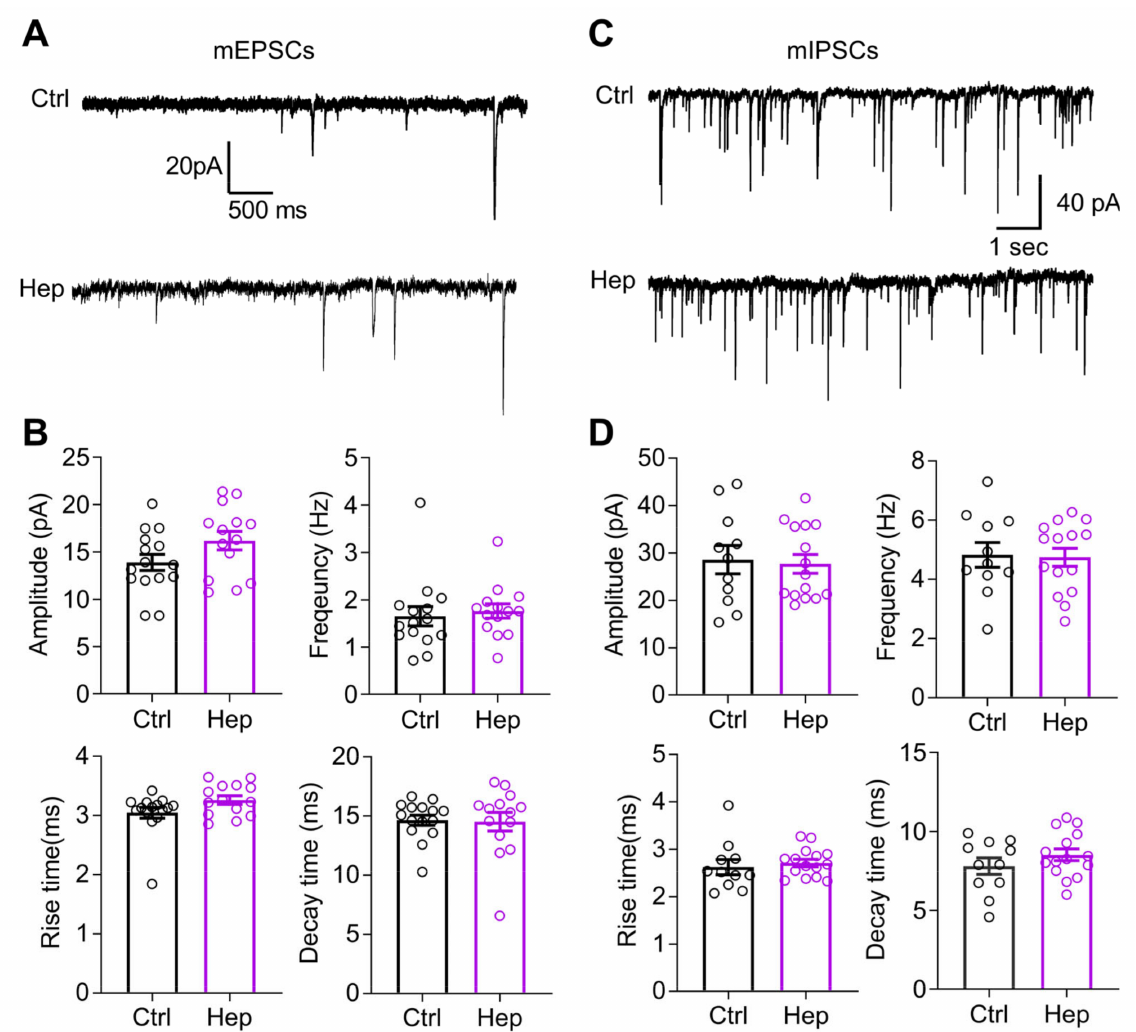
Figure 2. Intact excitatory and inhibitory synaptic transmission onto CA1 pyramidal cells one day after heparinase (Hep) injection into the mouse hippocampal CA1 in vivo. ( A ) Representative traces of mEPSCs from CA1 pyramidal cells in heat-inactivated (Ctrl) and active heparinase 1-injected mice in the presence of PTX, CGP55845, and TTX. ( B ) Summarized bar graphs show that amplitude, frequency, rise time, and decay time of mEPSCs remained intact after heparinase injection ( p > 0.05, two-tailed t -test; Ctrl, n = 15; Hep, n = 14). Data are presented as means ± SEMs. ( C ) Representative traces of mIPSCs recorded from CA1 pyramidal cells in heat-inactivated (Ctrl) and active heparinase 1-injected mice in the presence of NBQX (25 µ M), D-AP5 (50 µ M), CGP55845 (3 µ M), and TTX (1 µ M). ( D ) Summarized bar graphs show that amplitude, frequency, rise time, and decay time of mIPSCs remained intact after heparinase injection into the hippocampal CA1 area ( p > 0.05, two-tailed t -test; Ctrl, n = 15; Hep, n = 14). Data are presented as means ±